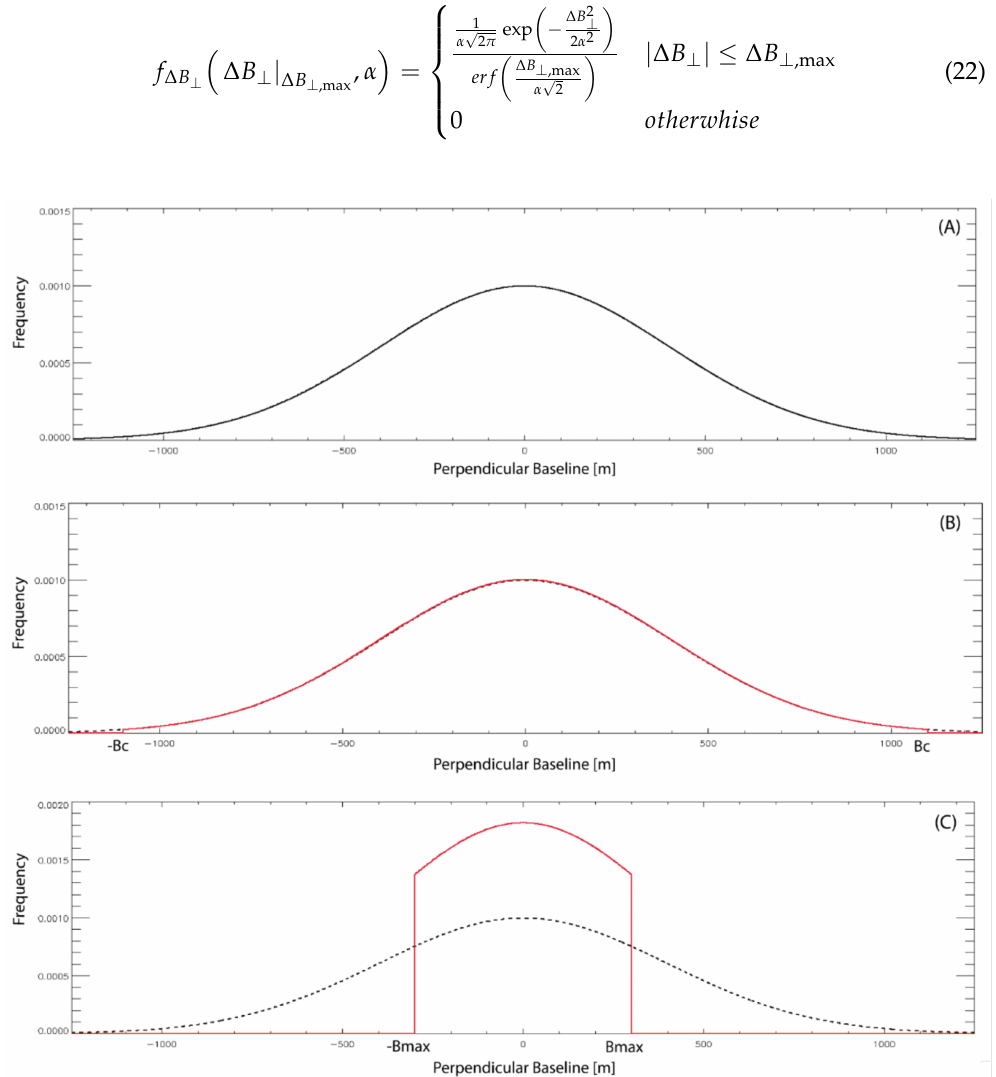
Figure 5. Theoretical Distribution of the perpendicular baselines of the InSAR data. ( A ) Normal distribution of the perpendicular baseline of InSAR data pairs. ( B ) Distribution of the perpendicular baselines of the InSAR data pairs below the critical baseline boundary. ( C ) Distribution of the per- pendicular baseline of the selected small baseline interferograms obtained by imposing a maximum allowed absolute perpendicular baseline equal to